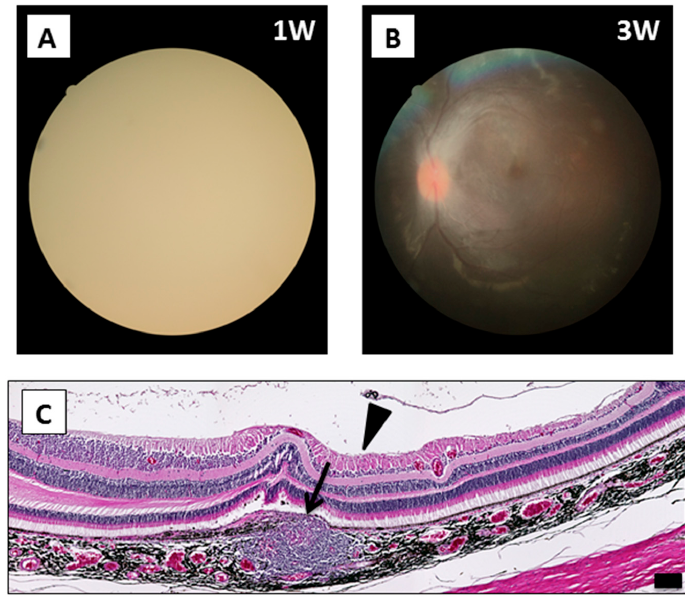
Figure 7. Surgical complications seen after the iPSC-RPE transplantation: sterile endophthalmitis. ( A ) The fundus photograph of monkey HM-8 at 1 week after transplantation. Endophthalmitis was developed, which made the fundus invisible. ( B ) The inflammation disappeared around 3 weeks after surgery without any treatment. ( C ) H&E staining at 12 weeks after transplantation showed the graft (arrow) and epiretinal membrane (ERM; arrowhead). We diagnosed this case as triamcinolone-related sterile endophthalmitis. Scale bar: 100 μ m.